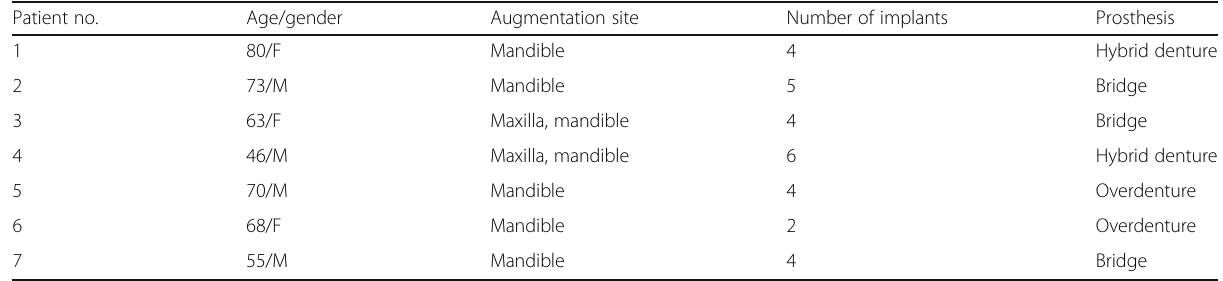
Table 1 Patient and treatment data Patient